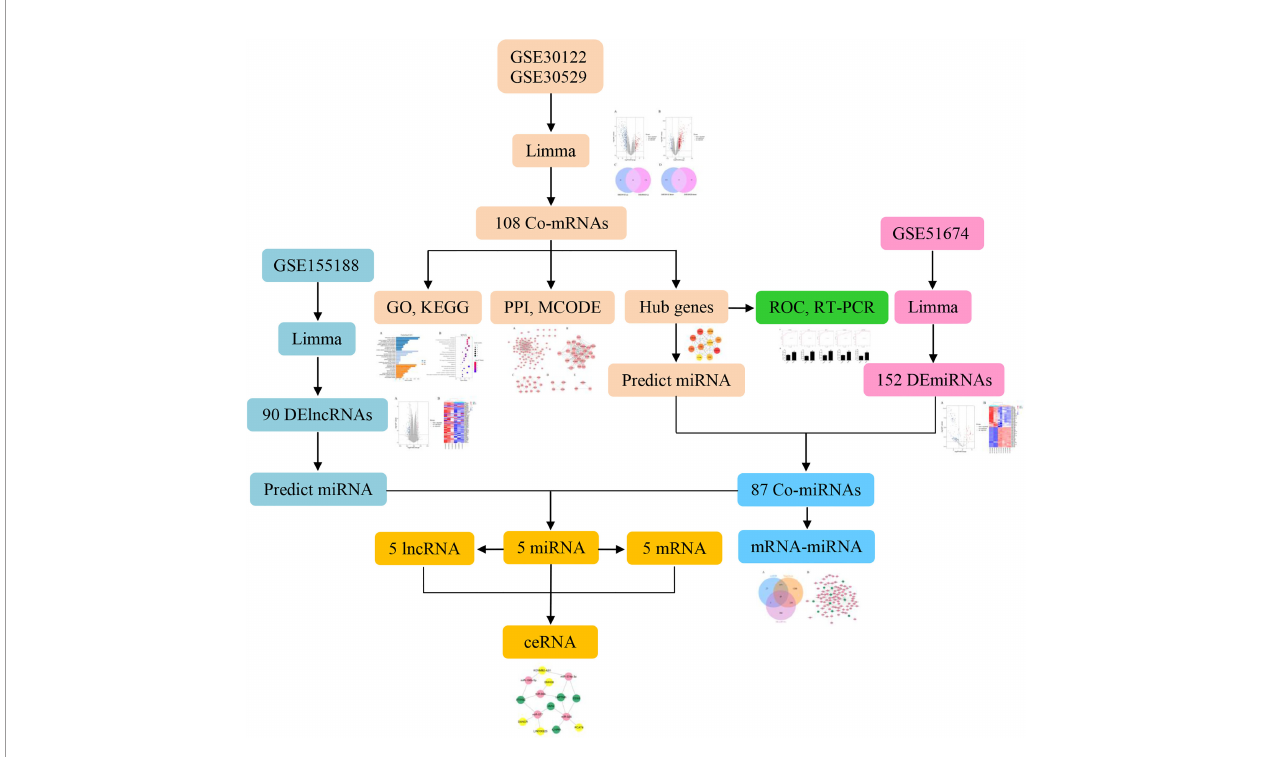
FIGURE 1 | Research fl ow